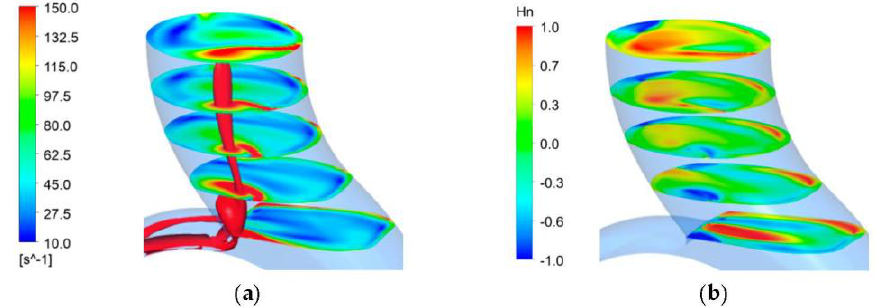
ff usion section: ( a ) Module distribution of vorticity; ( b ) H